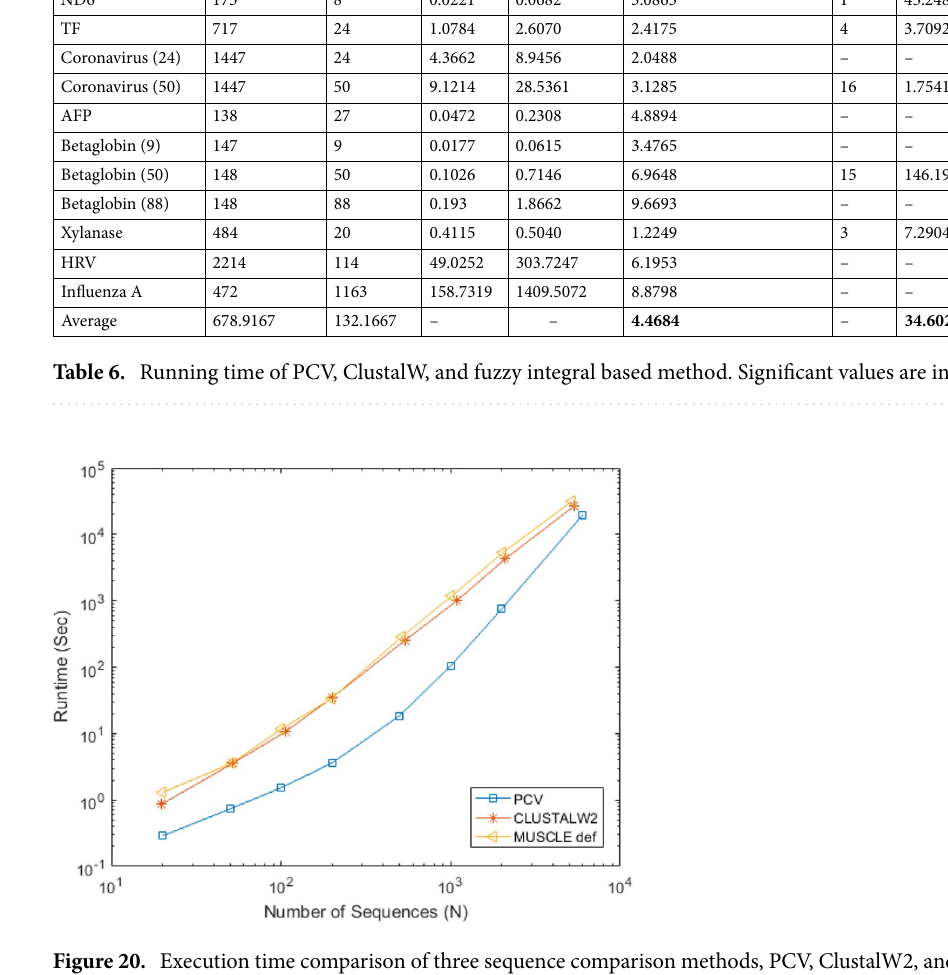
Figure 20. Execution time comparison of three sequence comparison methods, PCV, ClustalW2, and Muscle, for various numbers of input sequences. The sequences in this database are around 330 characters long, and execution times are measured on a system with a 4-core CPU running at 2.4 GHz and 12 GB of